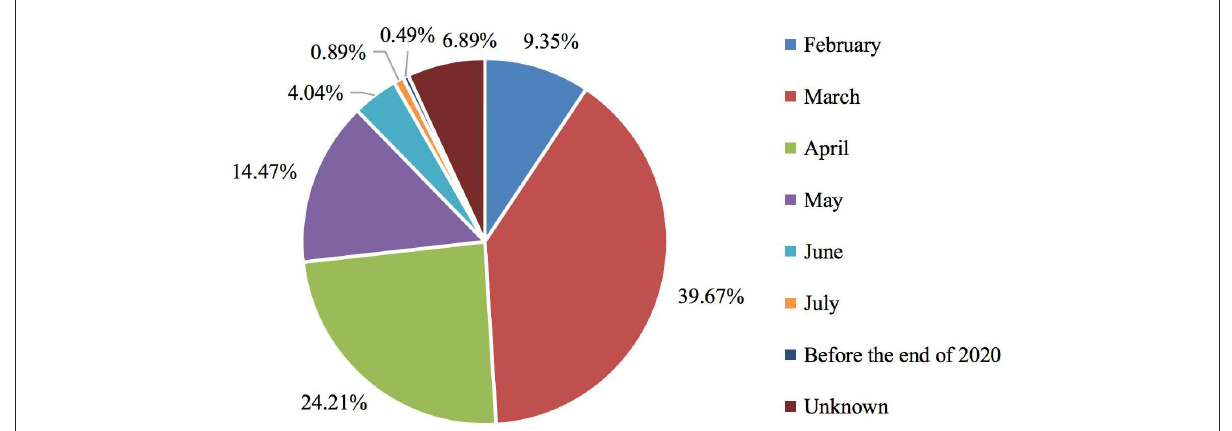
FIGURE2 Frequency distribution of residents’ expected month for controlling COVID-19 outbreak at the destination cities.